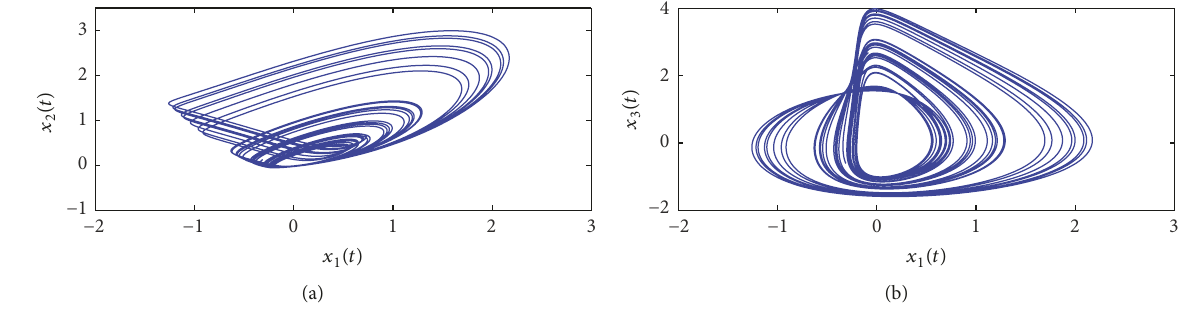
Figure 3: A chaotic attractor in system (2) for 𝑞 = 0.958 .